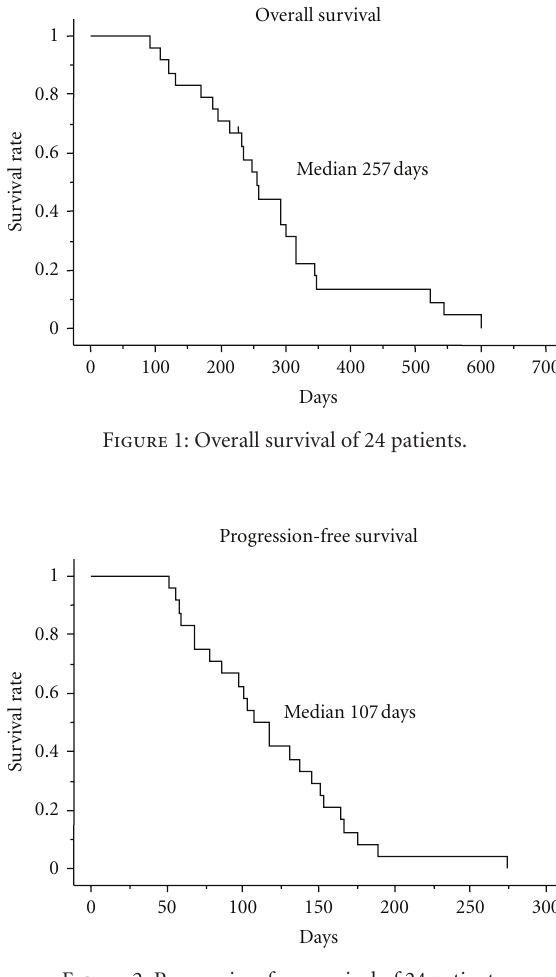
Figure 2: Progression-free survival of 24